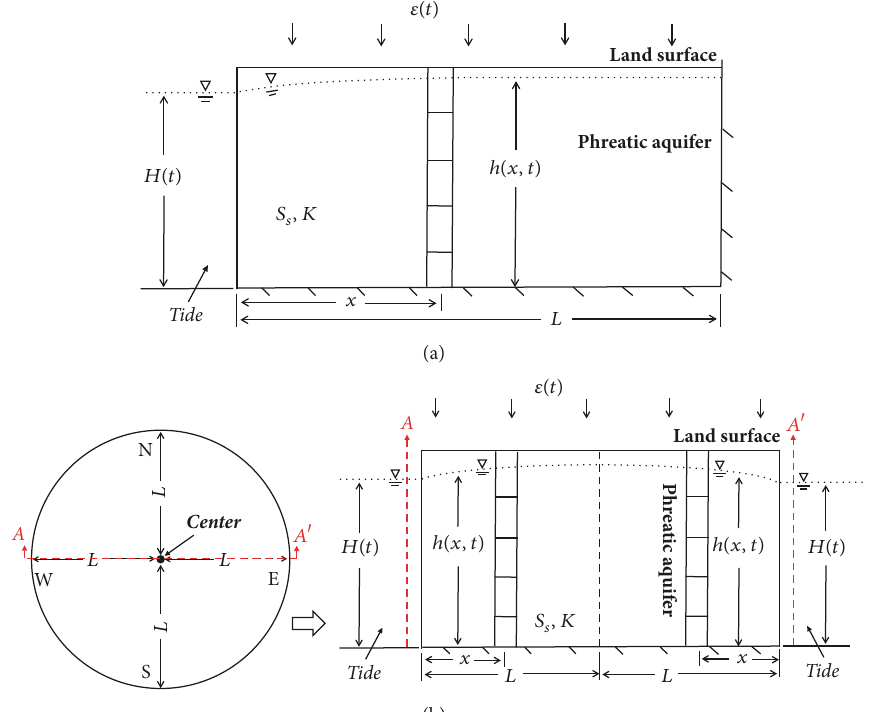
Figure 2: Phreatic aquifer scenarios of the (a) 1D Dupuit aquifer and (b) 2D axisymmetric Dupuit aquifer.